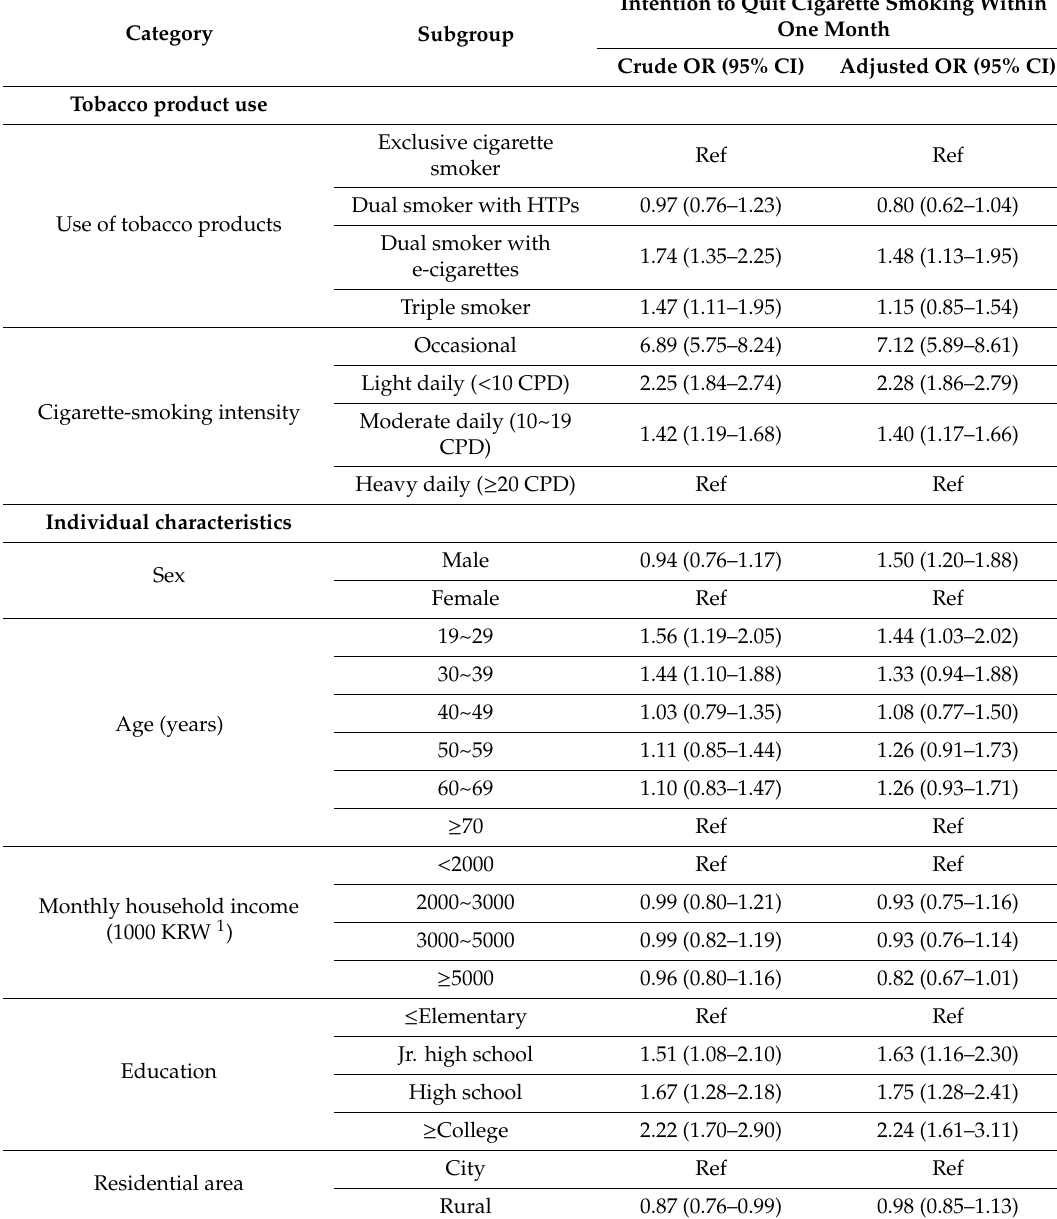
Table 2. Association between tobacco product use and intention to quit cigarette smoking within one